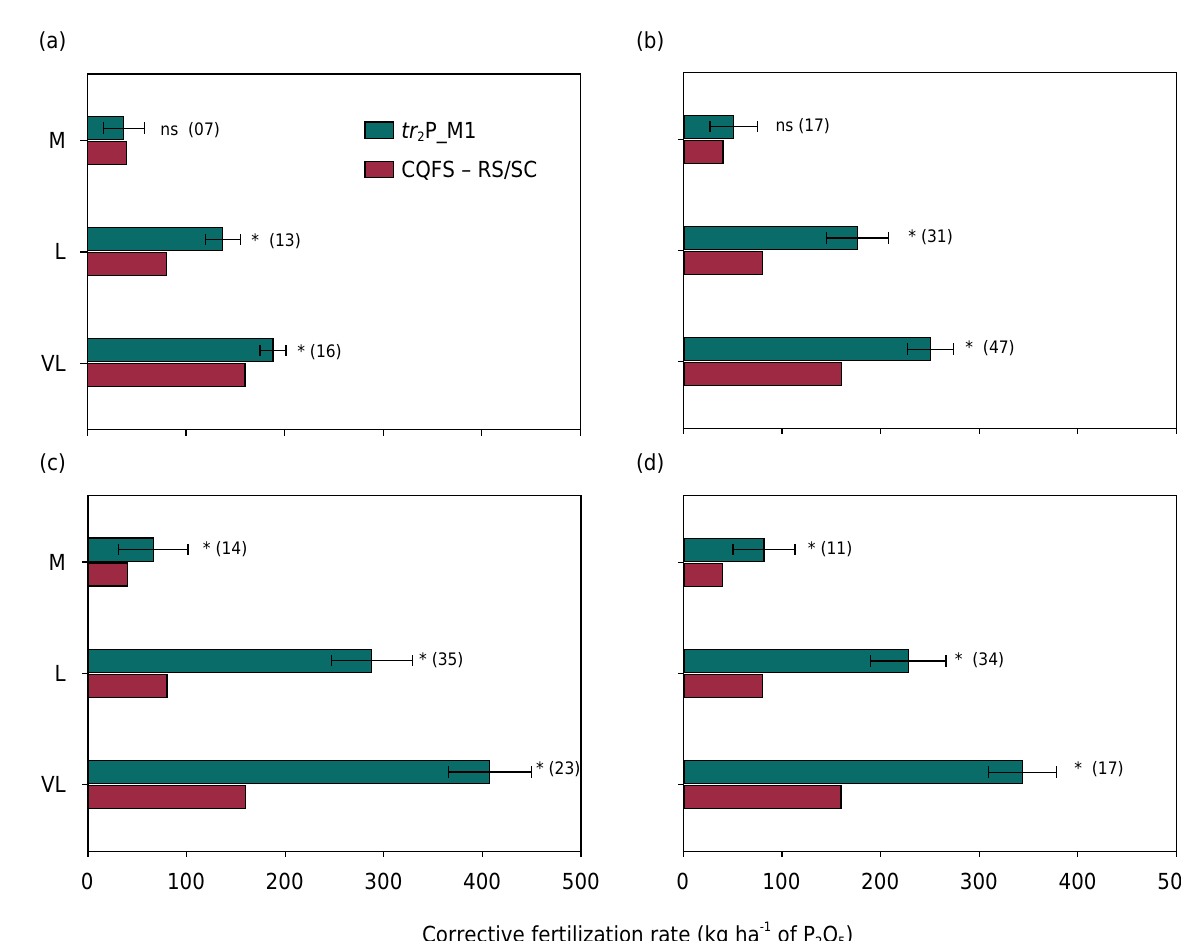
Figure 4. Comparison between corrective fertilization adopted by CQFS-RS/SC (2016) and the recommended by tr 2 P_M1 calculation, considering soils with <20 (a), 21 to 40 (b), 41 to 60 (c), and >60 % (d) of clay content, for phosphorus availability class of very low (VL), low (L), and medium (M) to 270 soil samples from Santa Catarina. Horizontal error bars at the top of the bars represent the standard deviation of the mean; ns: not significant; * statistically significant by student t-test (p<0.05); The numbers within bracket represent the number of observations for each